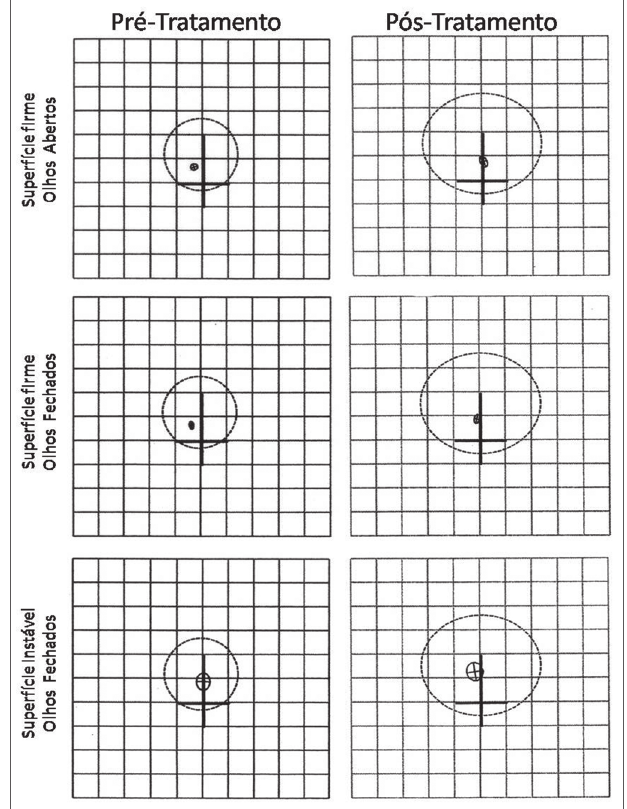
Figura 2. Posturografia do Balance Rehabilitation Unit, em idoso com VPPB, pré e pós manobra de Epley nas condições de superfície firme olhos abertos e fechados e superfície firme e olhos fechados. O círculo maior está representado pelo LE e o menor pelo COP. Após a manobra, o LE aumentou e o COP